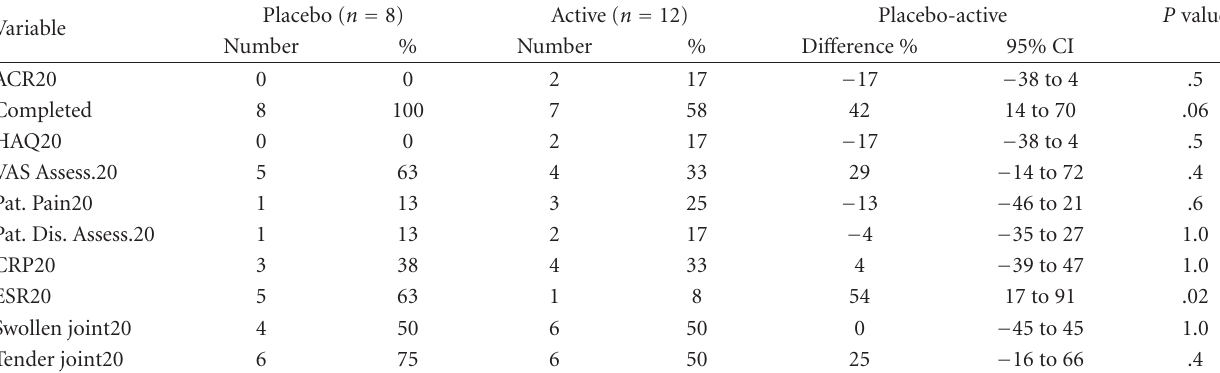
Table 3: Number and percentage of patients with an ACR20 response, together with the number of patients with a 20% improvement for each core variable. 20 after each variable indicates 20%